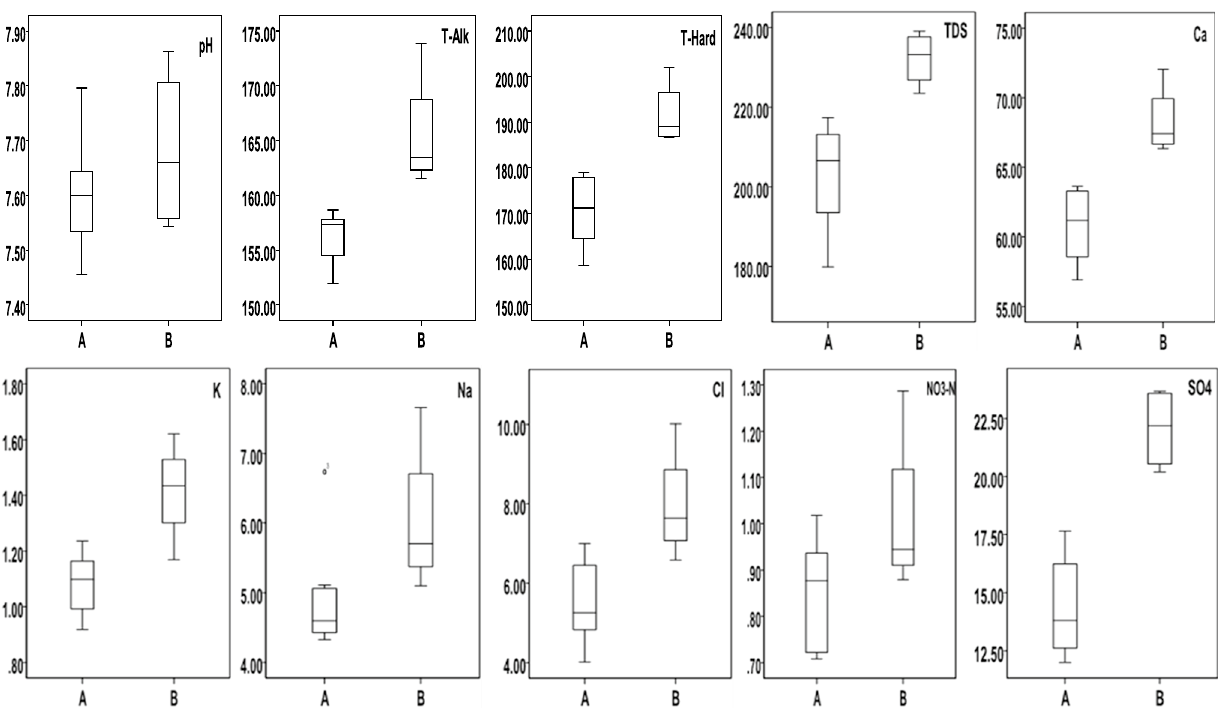
Fig. 2 Boxplot of Water Quality Index for the two clustered groups